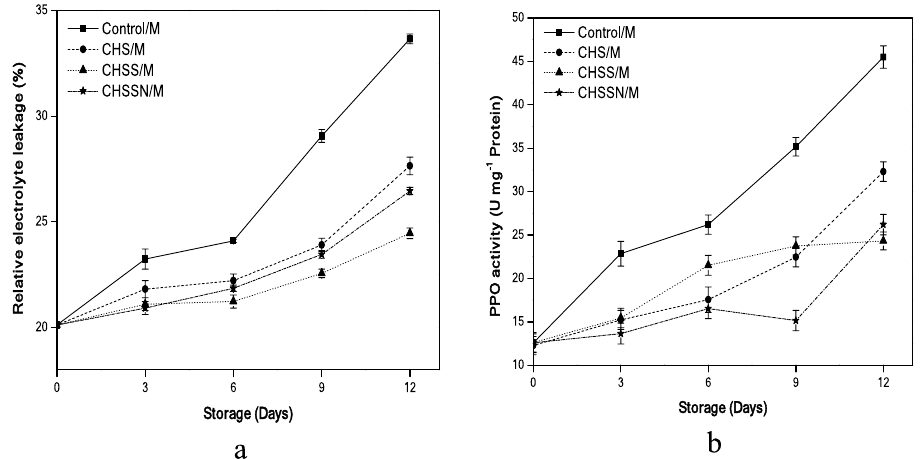
Figure 5. Effects of nano-coating treatments on membrane electrolyte leakage ( a ) and PPO enzyme activity ( b ).